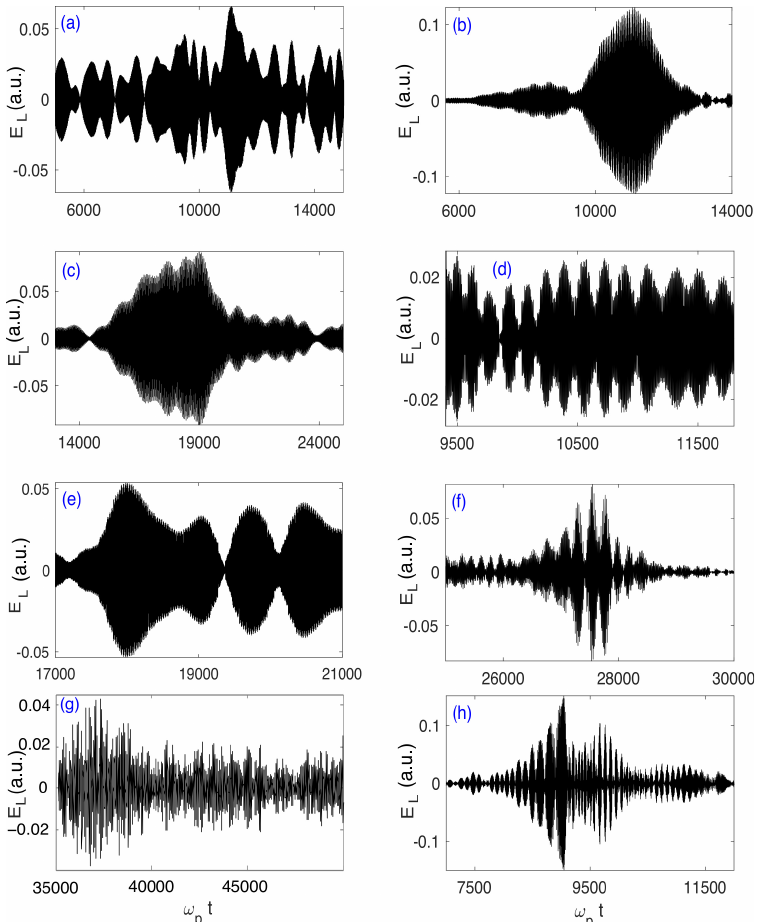
Figure 21. ( a – h ) Langmuir waveforms E L ( t ) (in arbitrary units) recorded by virtual satellites moving in random fluctuating inhomogeneous solar wind plasmas, calculated owing to numerical simulations. These exemples summarize all the main types of waveforms actually observed in the solar wind. Main parameters are the following: ( a ) v S / v T = 0.6, ∆ n = 0.001. ( b ) v S / v T = 0.1, ∆ n =